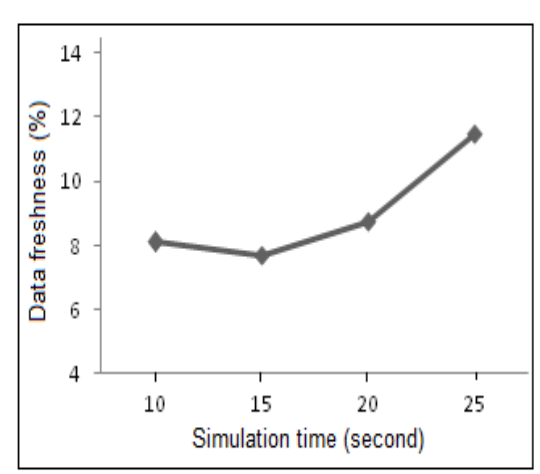
Figure 4. Data freshness vs simulation time